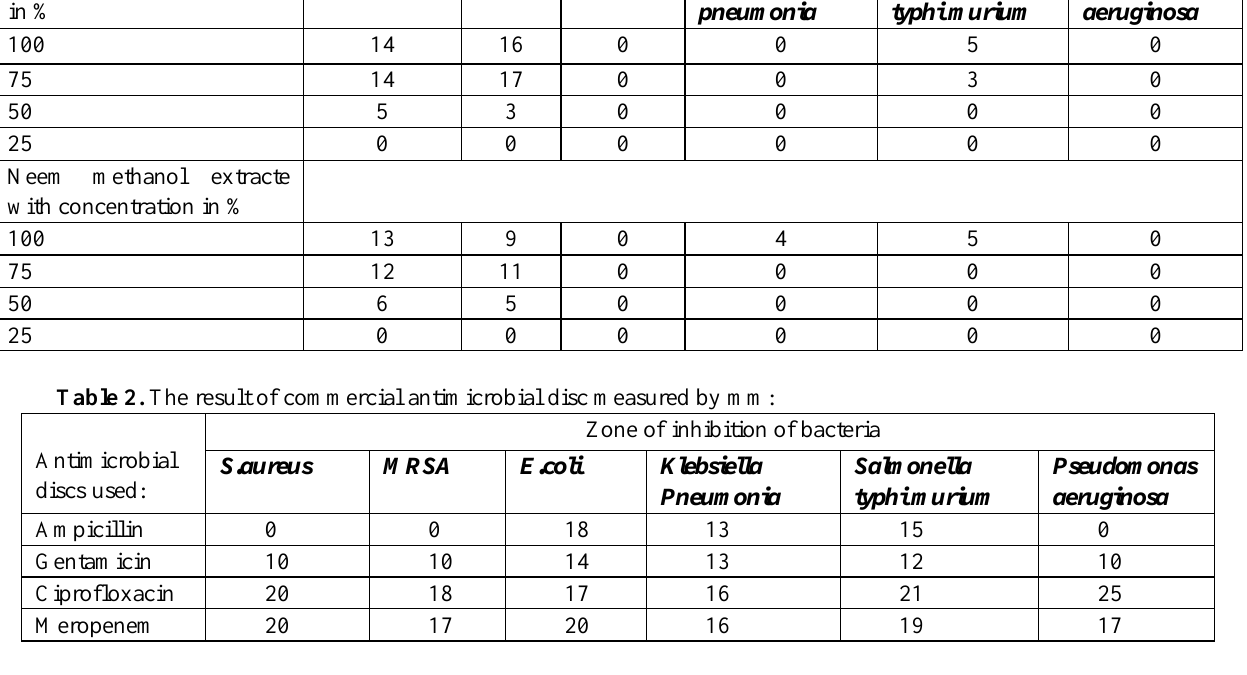
Table 1. Effect of different concentrations of Neem petroleum ether and methanol extract on the selected bacteria by measuring zone of inhibition in mm.